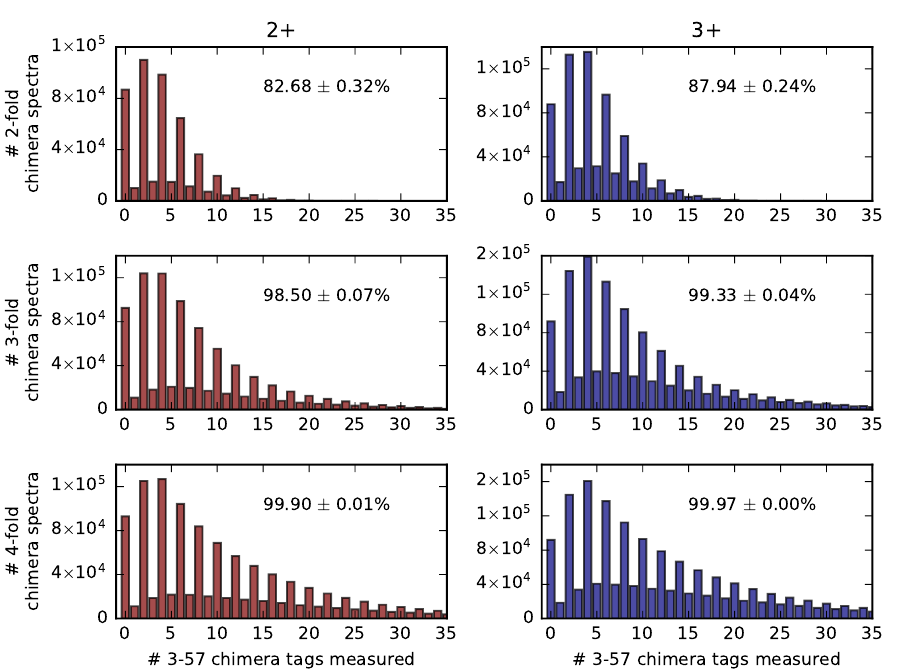
Figure 3. Histograms of the number of chimera tags predicted to be measured by 2D-PC-MS within the positive ion mode CID for two-, three-, and four-fold chimera spectra of 2+ ( left ) and 3+ ( right ) tryptic peptide ions derived from the Swiss-Prot database. The lowest rate of chimera spectra detection is predicted to be approximately 83% (in the two-fold chimera spectra of the doubly charged ions), demonstrating the usefulness of the